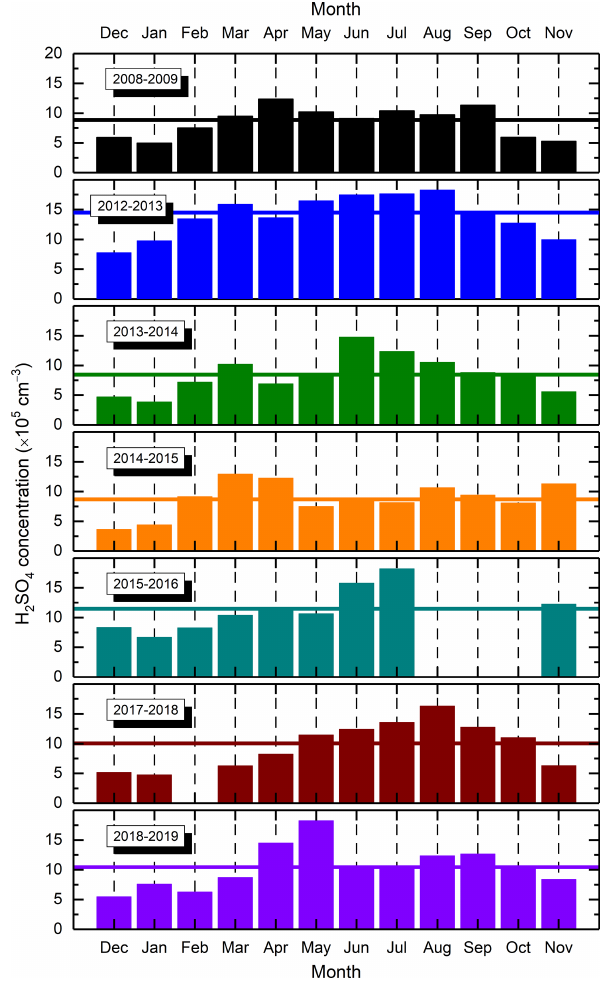
Figure 4. Distribution of the monthly median gas-phase H 2 SO 4 concentration for the 7 measurement years. The values for August– October 2016 and February 2018 are not available. The horizon- tal lines indicate annual medians. The measurements in 2012–2013 were performed in the near-city background, whereas in the other years, they were accomplished in the city centre.